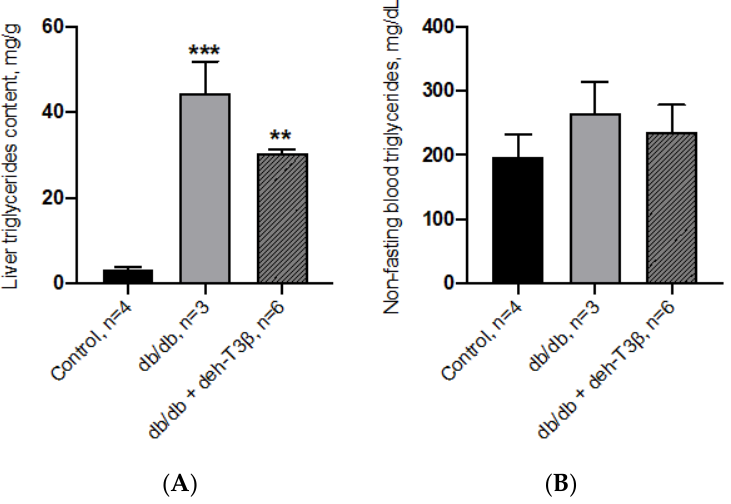
Figure 15. Triglyceride levels in the liver ( A ) and in plasma ( B ) of control C57BL6 mice and db/db mice non-treated or treated with deh-T3β in the diet for two months, ** p < 0.001, *** p < 0.001. The liver enzymes AST and ALT decreased by 50% in db/db mice treated with deh- T3β after one month compared to non-treated mice (not shown). However, treatment with deh-T3β did not affect the non-fasting plasma glucose levels, while the fasting levels de- creased from a mean of 10 to 8 mmol/L in the db/db mice. The non-fasting levels were 20– 30 mmol/L, independent of the treatment after one month. Body weight (40–50 g) was not